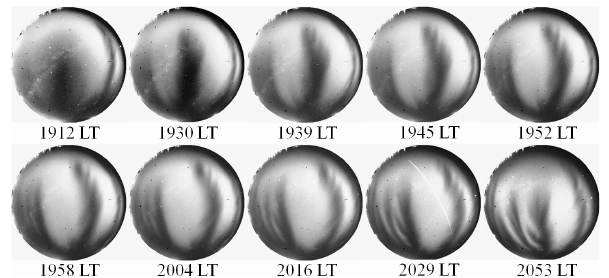
Fig. 5. Sequence of depletions taken in the night of 23 October 2000, from Mt. Alishan, revealing the unstable eastern wall with complex secondary patterns. The orientation of the images is same as that in Fig. 1.